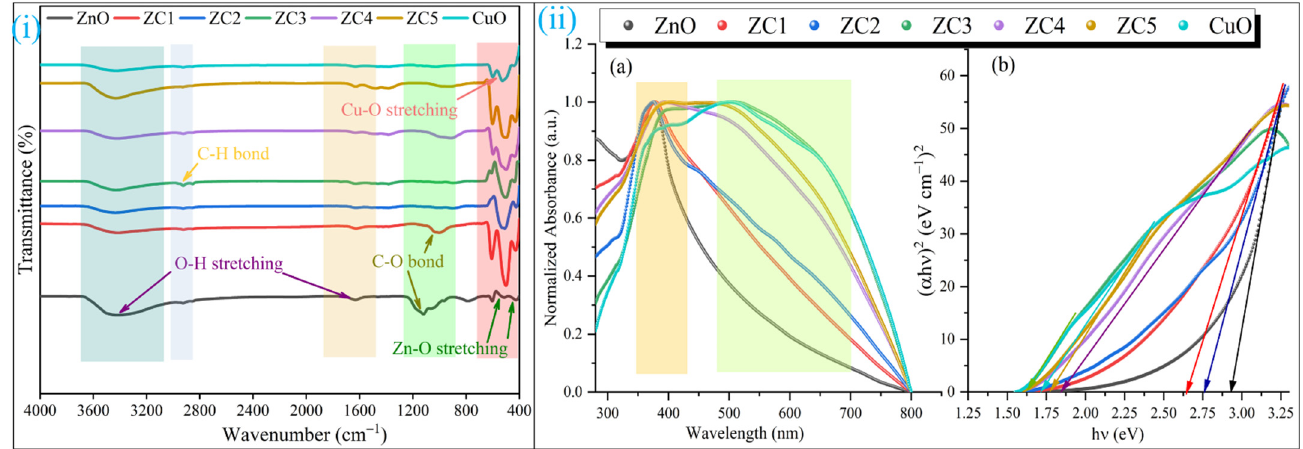
Figure 2. ( i ) FT-IR micrograph of ZnO, ZnO/CuO, and CuO nanoparticles. ( ii ) ( a ) UV-vis spectra of absorbance vs wavelength and ( b ) Tauc plot of ZnO, CuO, and ZnO/CuO.